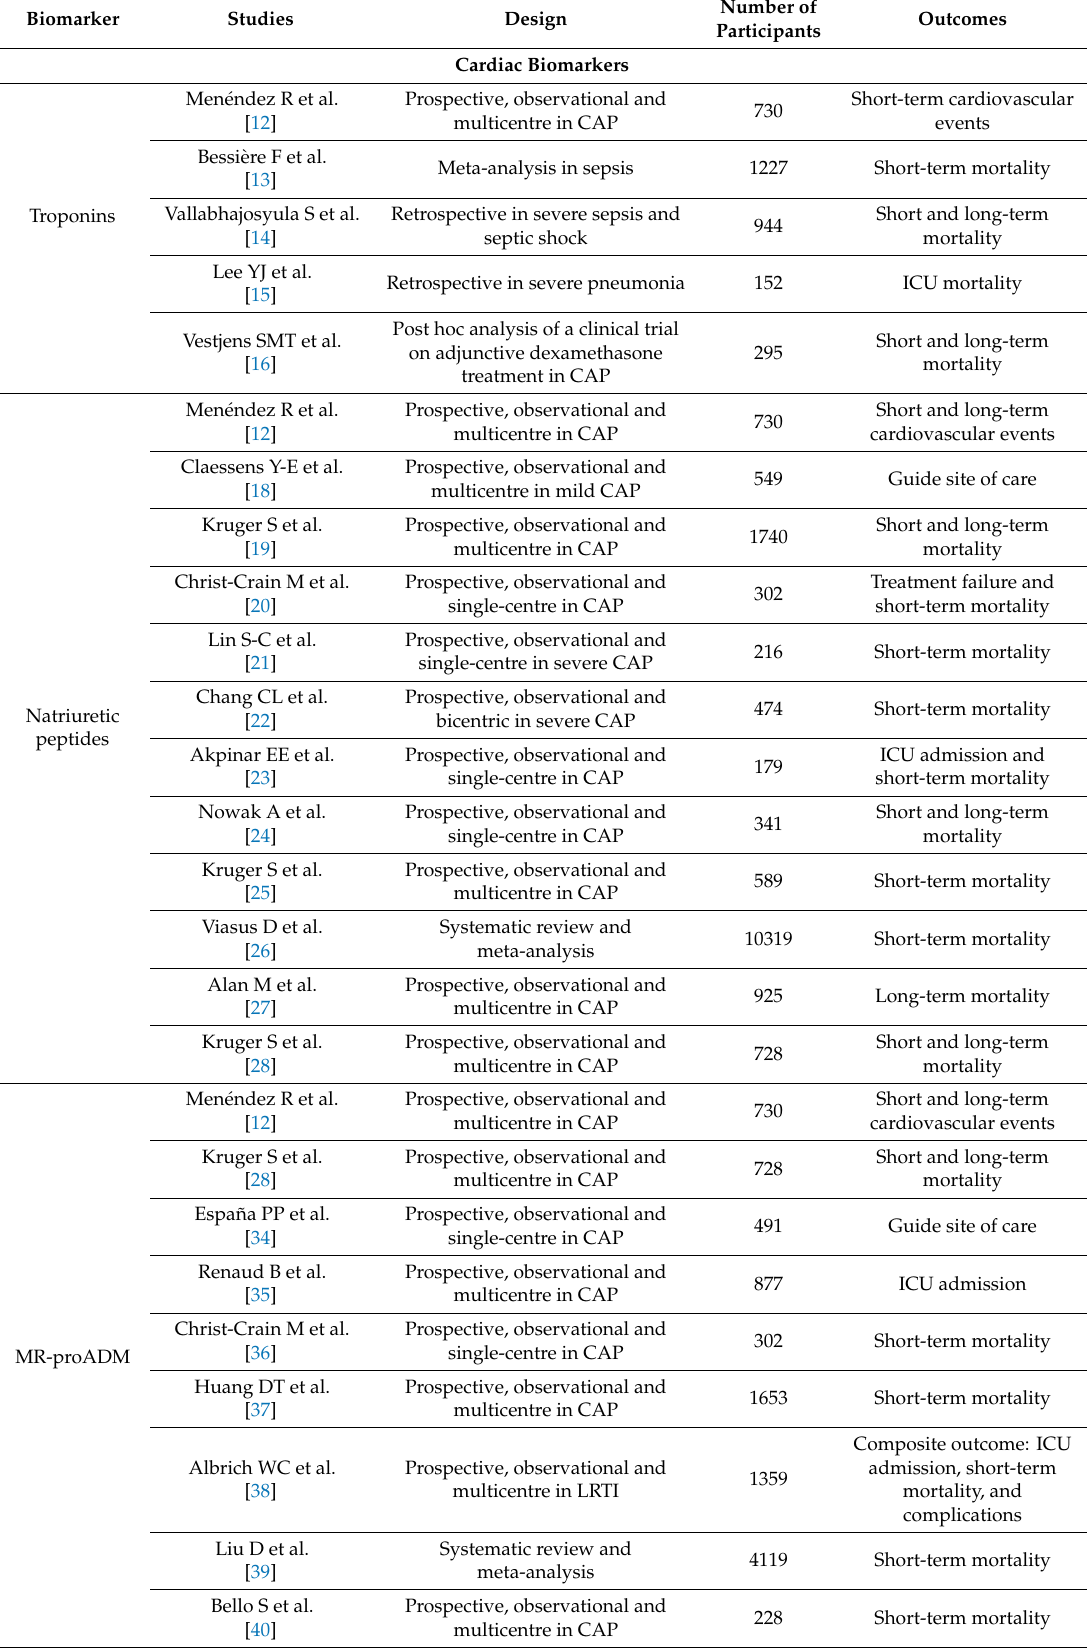
Table 2. Cardiac biomarkers, type of studies, design, and outcomes are